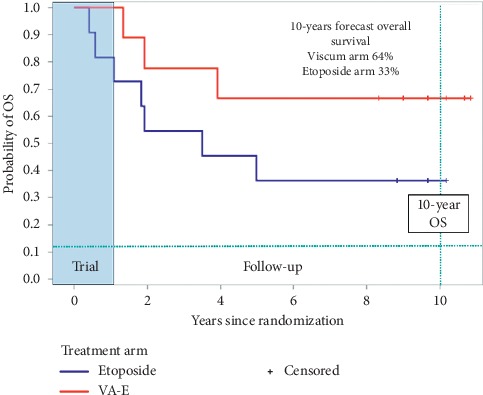
Overall survival.